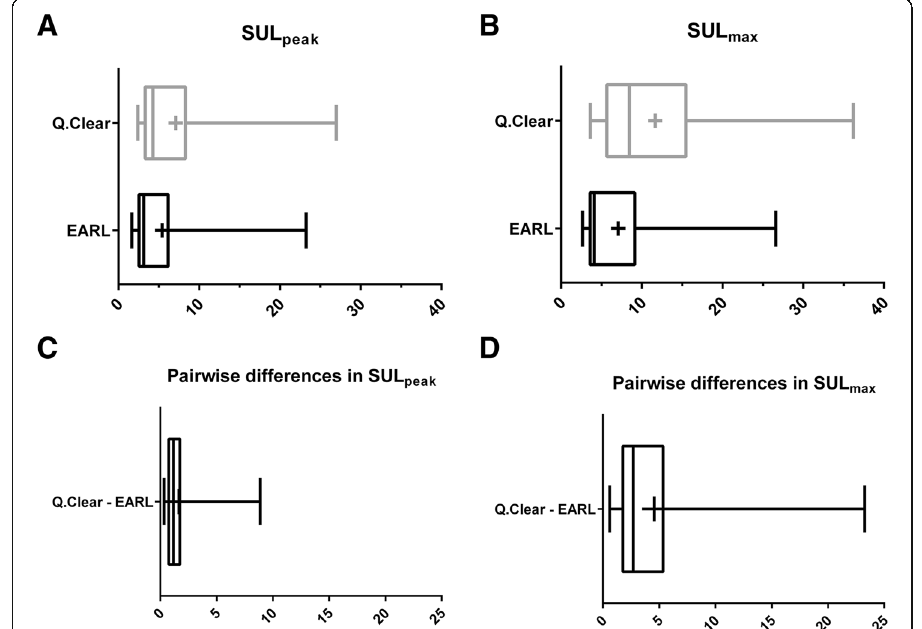
Fig. 3 Boxplots showing the distribution of lesion SUL peak ( a ) and SUL max ( b ) and pairwise differences ( c , d ) between the two reconstruction